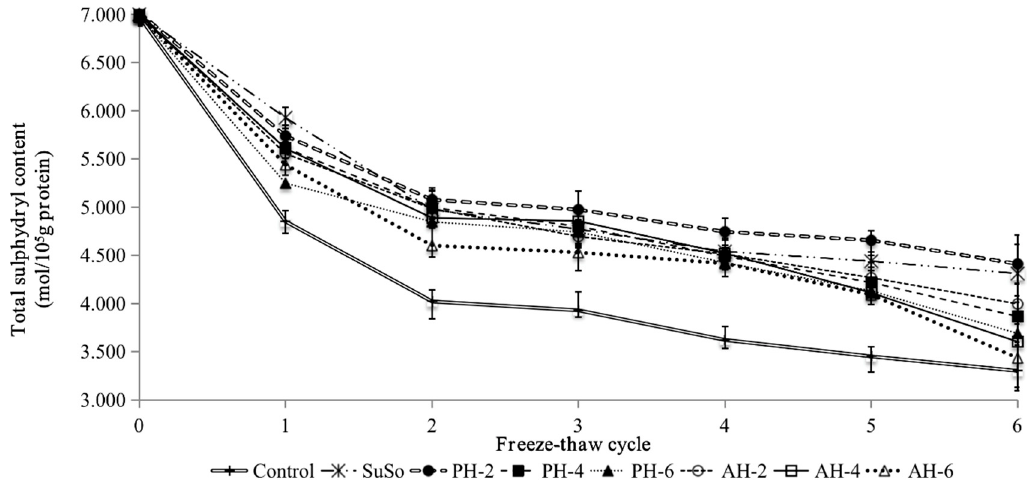
Figure 4. Total sulfhydryl content of actomyosin from different surimi samples during freeze-thaw cycles. SuSo (surimi added with sucrose-sorbitol blend); PH-2, PH-4 and PH-6 (surimi with addition of 2, 4, and 6 g of the hydrolysate prepared by Protamex hydrolysis, respectively); AH-2, AH-4 and AH-6 (surimi with addition of 2, 4, and 6 g of the hydrolysate prepared by Alcalase hydrolysis, respectively); and control (surimi without cryoprotectant). The reported data represent mean values from three replications. Bars represent standard deviations.